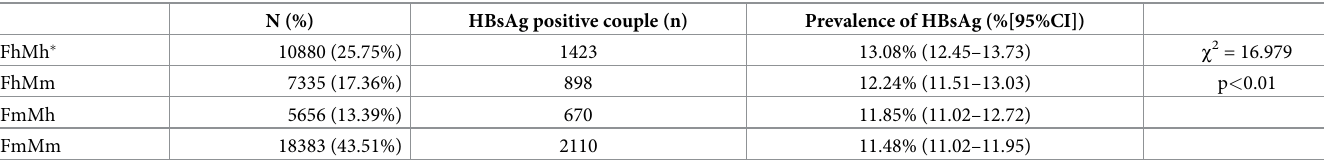
Table 2. Couple prevalence of HBsAg by ethnic origin in southeastern